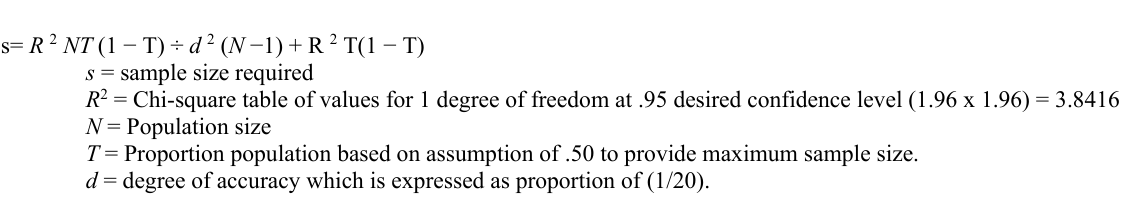
Note.— N is population size.